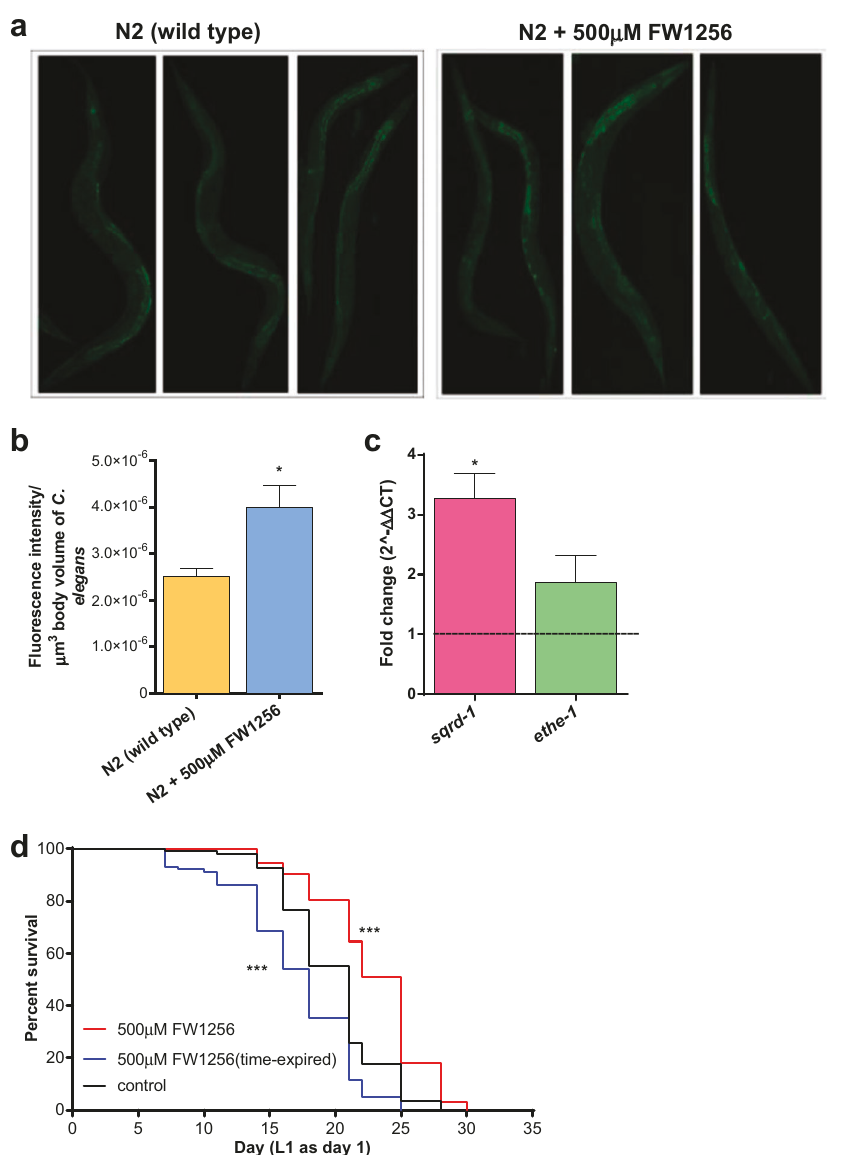
Fig. 2 H 2 S moiety from FW1256 is the key of longevity increase. a Confocal microscopy fl uorescence images of H 2 S detection using AzMC (in green) in C. elegans b Fluorescence intensity of the AzMC signal, normalized to body volume of C. elegans ( n = 5 animals per condition, t -test, * p < 0.05) . c Relative quanti fi cation mRNA levels of sqrd-1 and ethe-1 encoding for endogenous H 2 S detoxi fi cation system in WT C. elegans exposed to 500 µM FW1256. Data show expression of sqrd-1 and ethe-1 relative to WT control ( n = 3 repeated experiments, one sample t -test, * p < 0.05). d Effect of time-expired FW1256 (500 µM, 4 weeks at room temperature) on lifespan of WT C. elegans ( n = 102 – 163 animals per condition, log-rank tests, *** p <